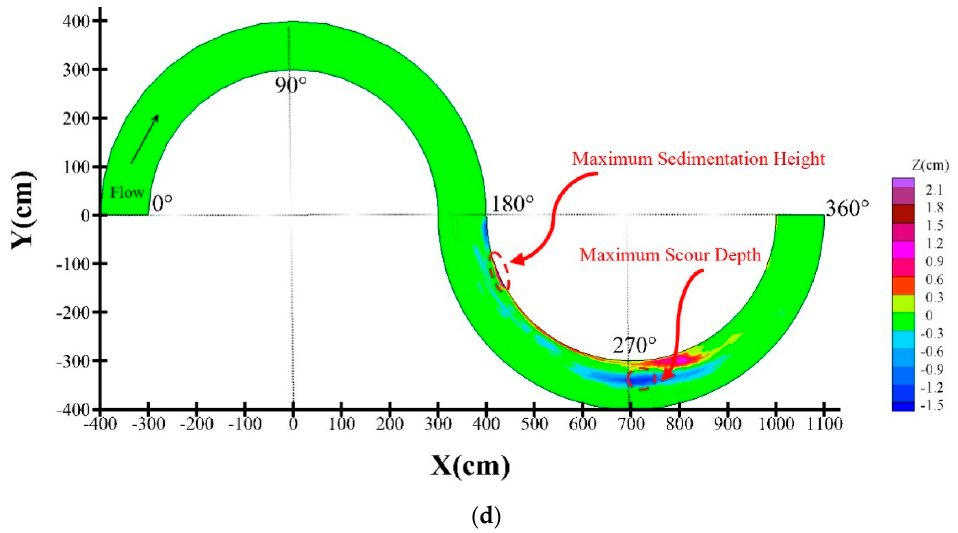
Figure 3. Bed topography variations for different U/Uc values: ( a ) 0.75, ( b ) 0.8, ( c ) 0.84, and ( d ) 0.86.